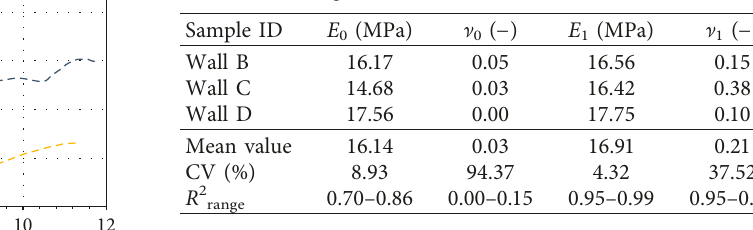
Table 2: For each specimen, elastic moduli and Poisson’s ratio of the first and second phases, that is, E 0 , ] 0 and E 1 , ] 1 , along with related mean values, coefficient of variation (CV), and range of coefficients of regression ( R 2 ).